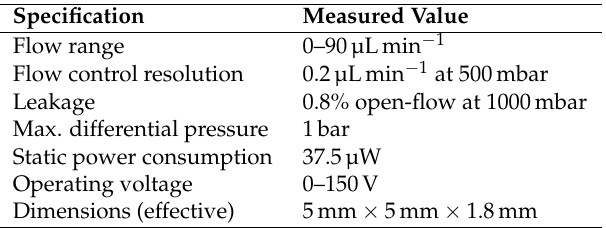
Table 2. Obtained Microvalve specifications.